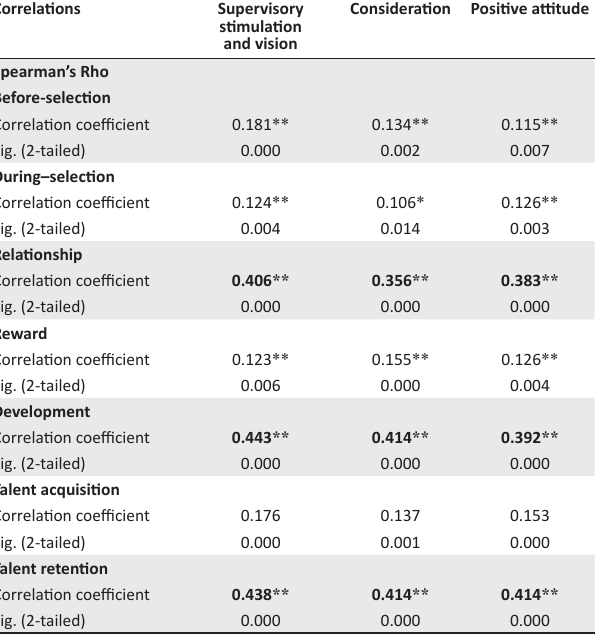
TABLE 8: Correlation between all eight sub-factors.